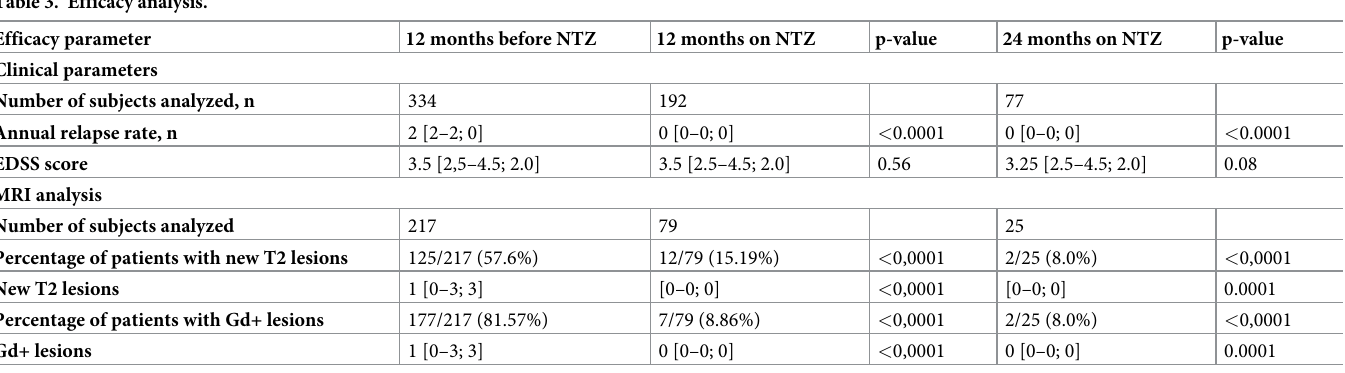
Table 3. Efficacy